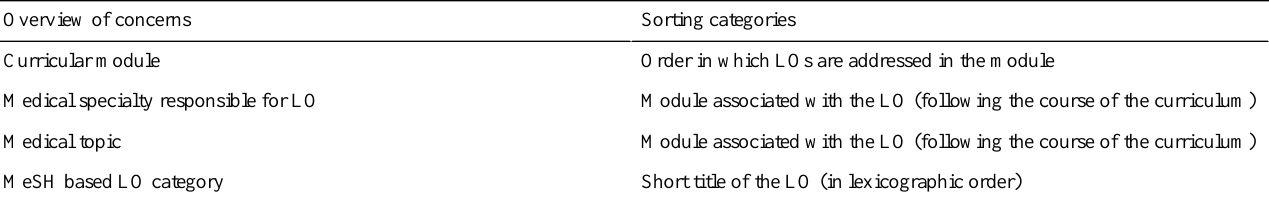
Table 1. Default ordering corresponding to different types of LO overviews.